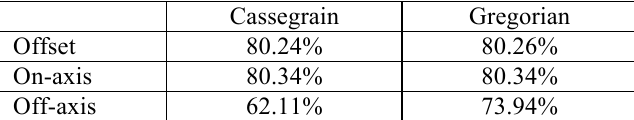
Table 7: Aperture efficiencies of Cassegrain and Gregorian antennas.